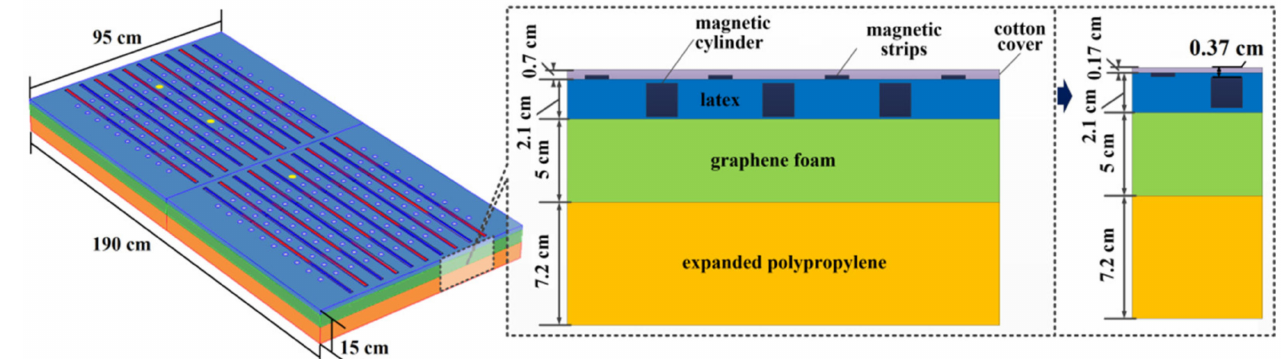
Figure 1. Numerical model of the magnetostatic mattress. The magnetic strips were aligned, with south poles at both ends and the north pole in the middle (S1-N-S2) or the south pole in the middle and the north poles at both ends (N1-S-N2) [24]. In the figure, red represents the south pole, and blue represents the north pole. Yellow represents the position of magnetic field